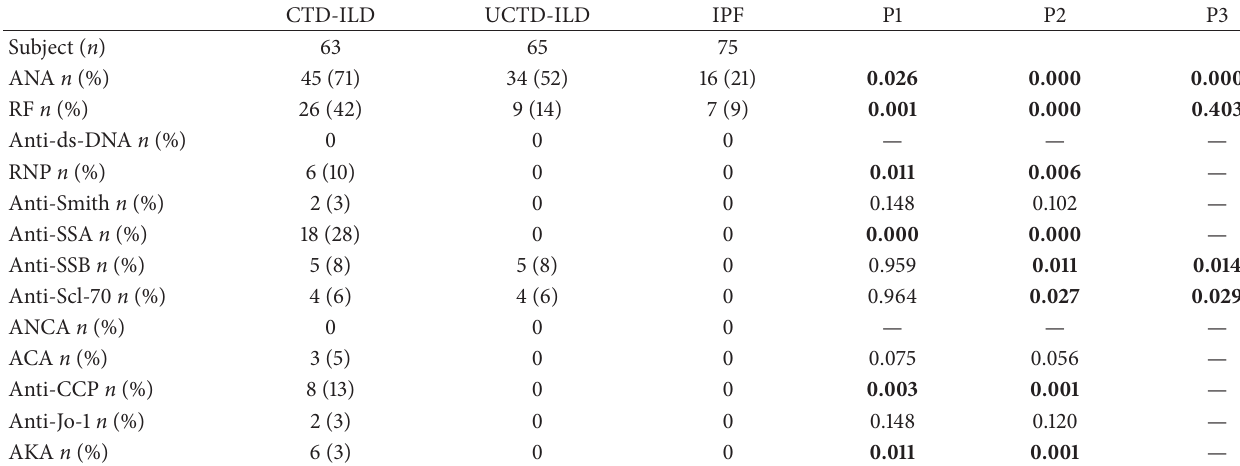
Table 3: Comparison of presence of autoantibodies among CTD-ILD, UCTD-ILD, and IPF